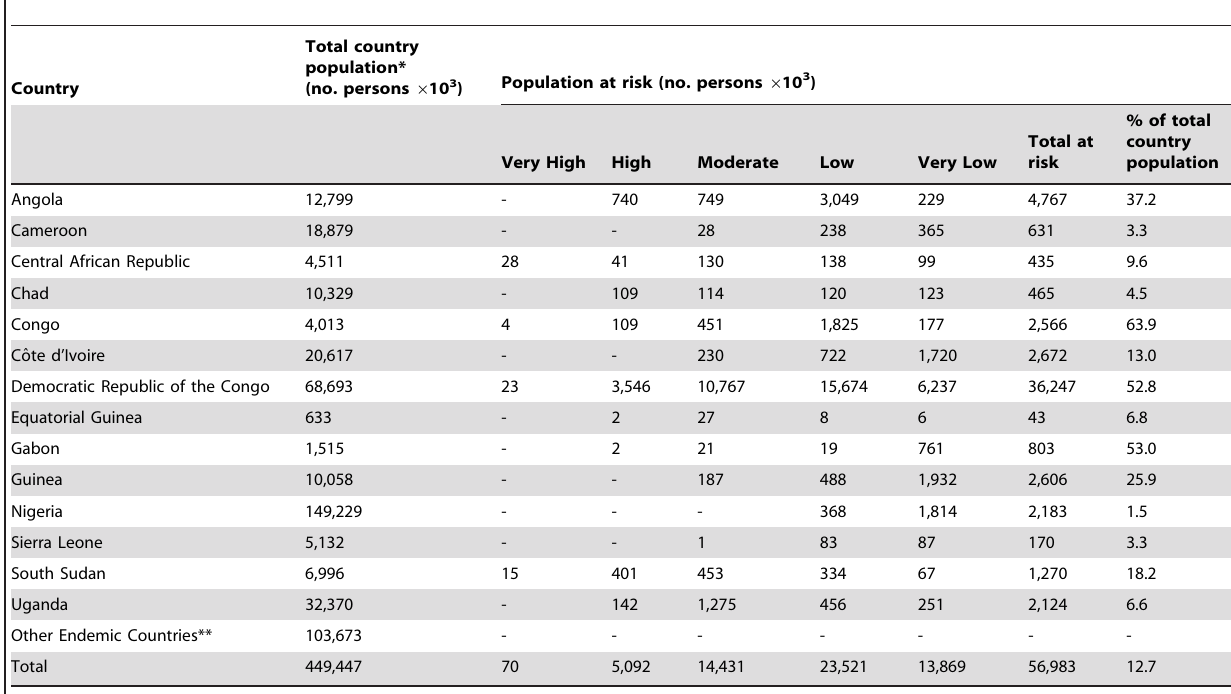
Table 4. Population at risk of T. b. gambiense infection in western and central Africa (no. persons 6 10 3 ).